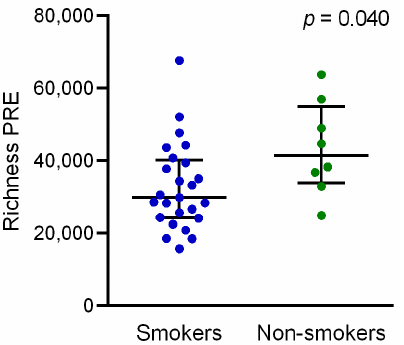
Figure 2. Peripheral TCR- β clone richness stratified by smoking status in pretreated NSCLC patients. P -value was obtained using the Mann–Whitney test. Error bars represent the interquartile range with a line at the median. Each dot represents a patient. Non-smokers: never smokers + former smokers. PRE: pretreatment.